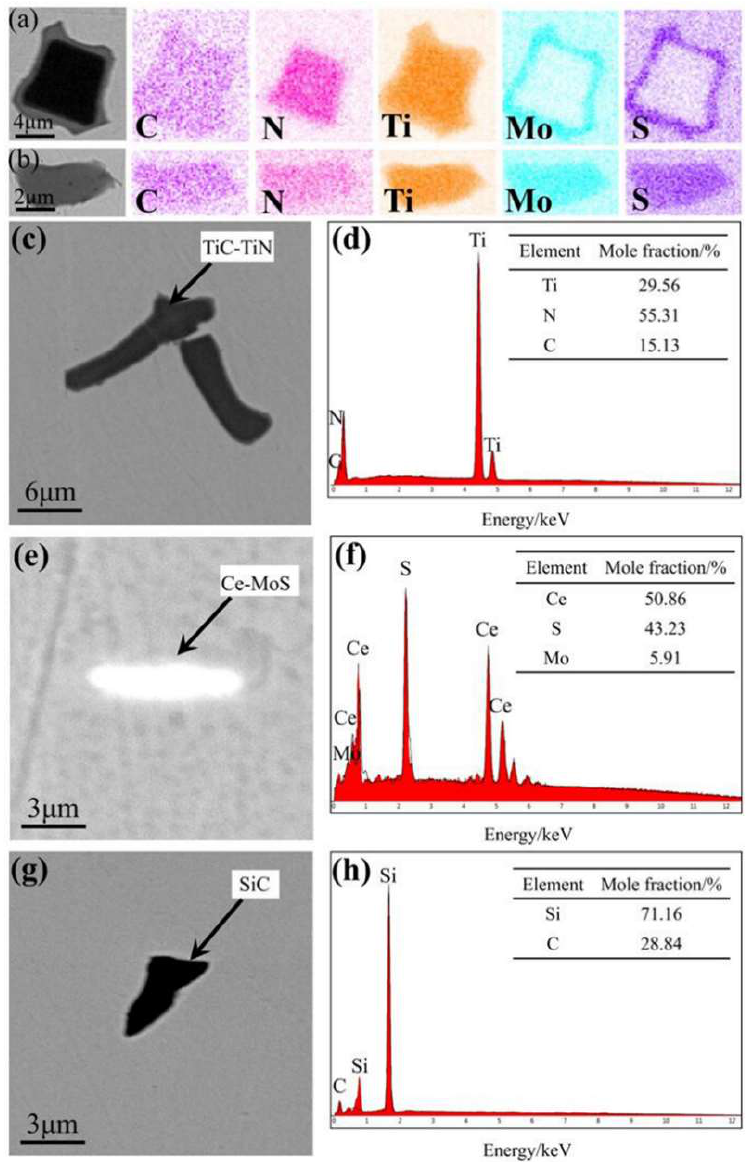
Figure 3. SEM images and EDS mapping of dominant inclusions. ( a , b ) TiC–TiN–Mo–S; ( c , d ) TiC–TiN; ( e , f ) Ce–Mo–S; ( g , h ) SiC.